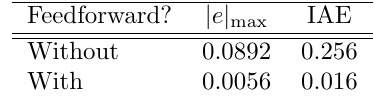
Table 3: Results for temperature control with and without feedforward control, but with feed- back PI control in both